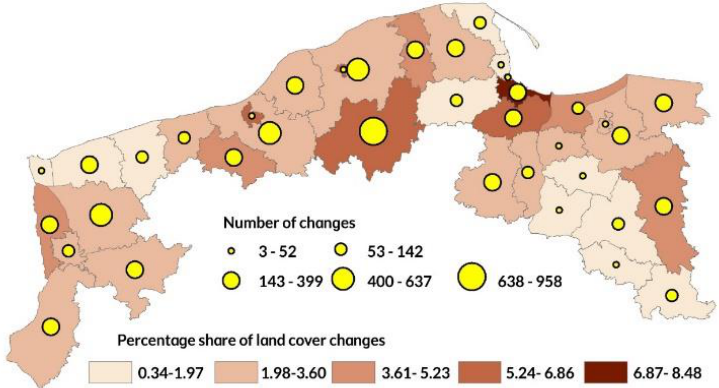
Figure 5. The percentage share of the land cover changes and the number of change polygons by counties (NUTS4 administration units in Poland).